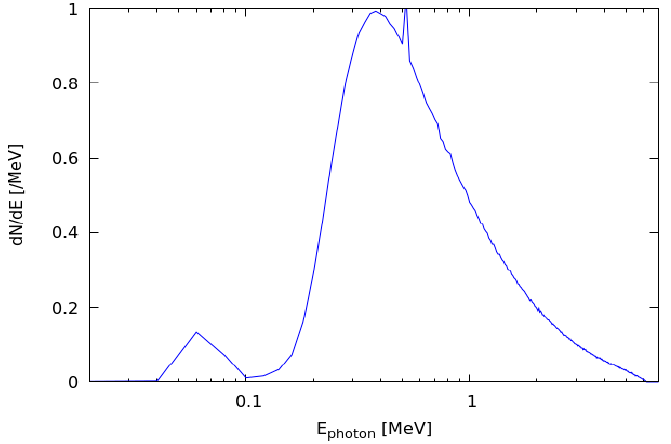
Figure 2. Geant4 simulated ORIATRON X-ray energy spectrum [41,42].